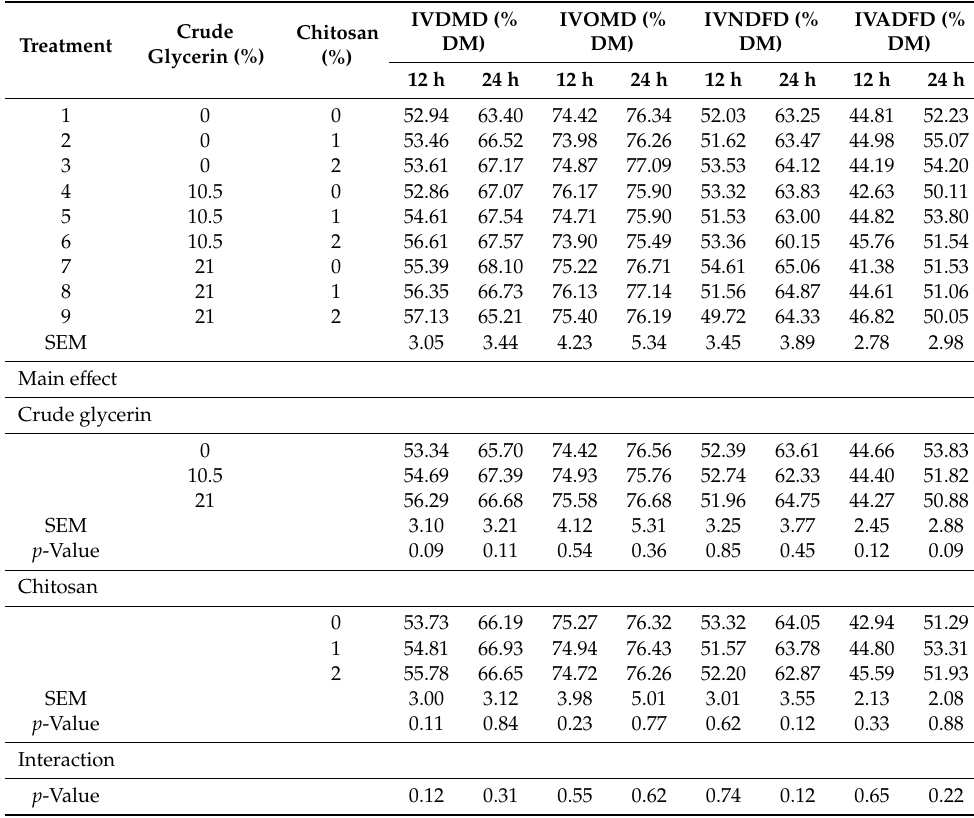
Table 4. Influence of crude glycerin with chitosan on in vitro digestibility of nutrients after 12 and 24 h of incubation using in vitro gas production technique.